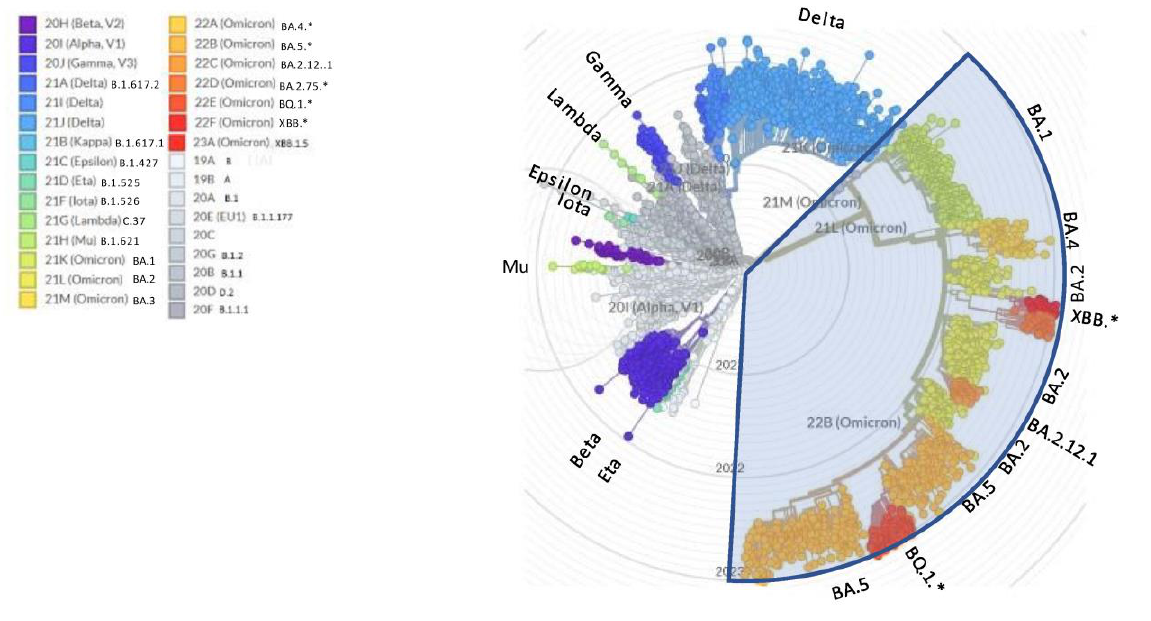
Figure 1. NextStrain radial view of SARS-CoV-2 phylogenetic tree. The legend shows the corresponding WHO variants of concern (VOC) and PANGOLIN names. * asterisk indicates that sublineages are included in the variant